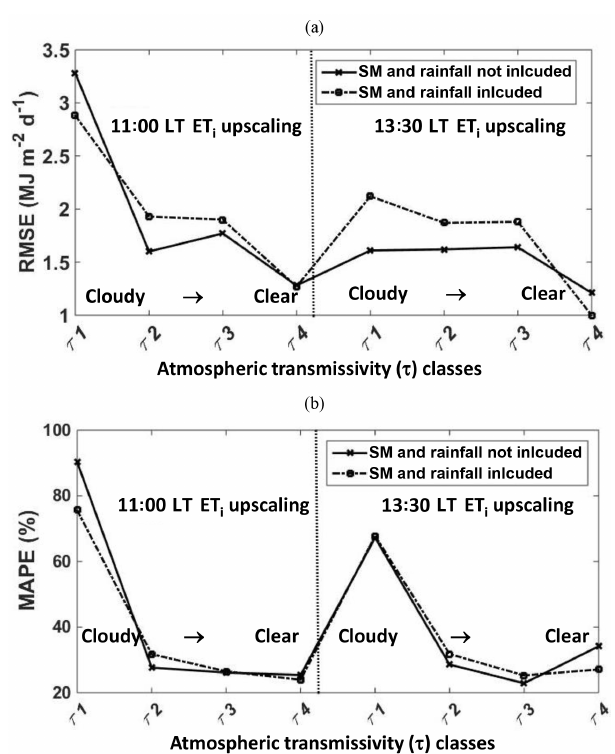
Figure 9. An intercomparison of ET d_pred error statistics (RMSE and MAPE) for different levels of atmospheric transmissivity classes based on two different ANN training (ANN trained with shortwave radiation and astronomical variables only; and ANN trained with radiation, astronomical variables, soil moisture, and rainfall) based on 11:00 and 13:30LT time-of-day ET i scaling.